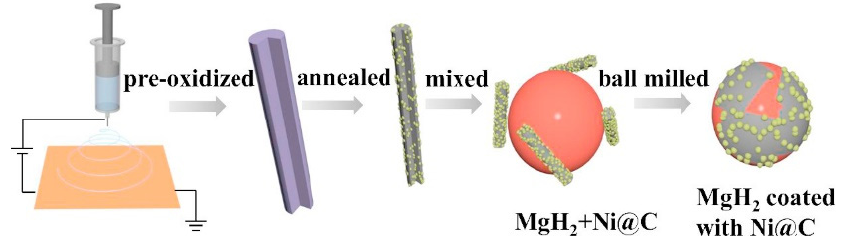
Figure 4. Schematic illustration for the Ni@C formation process and the synergetic catalytic effect on MgH 2 . Copyright 2021, Elsevier. Reproduced with permission from [74].